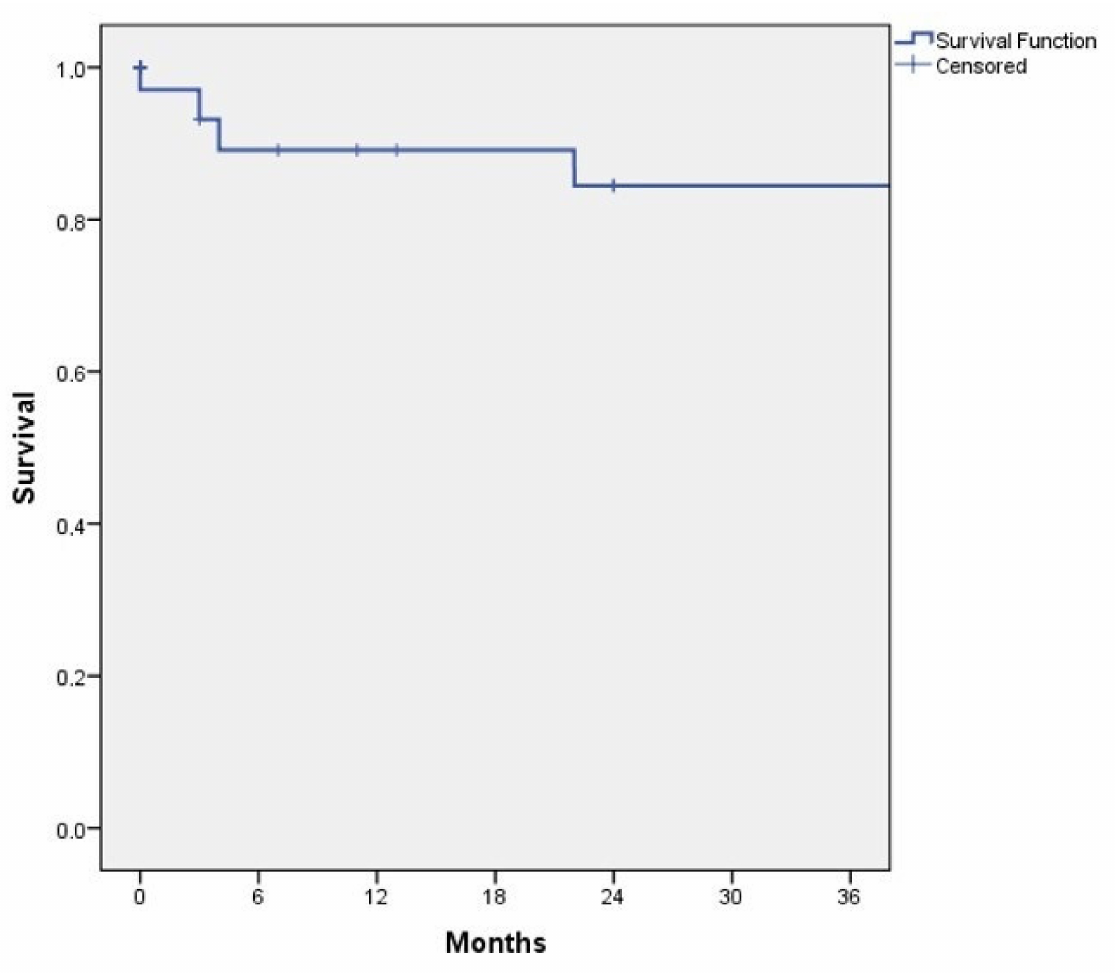
Figure 2. Kaplan–Meyer analysis of patient survival during